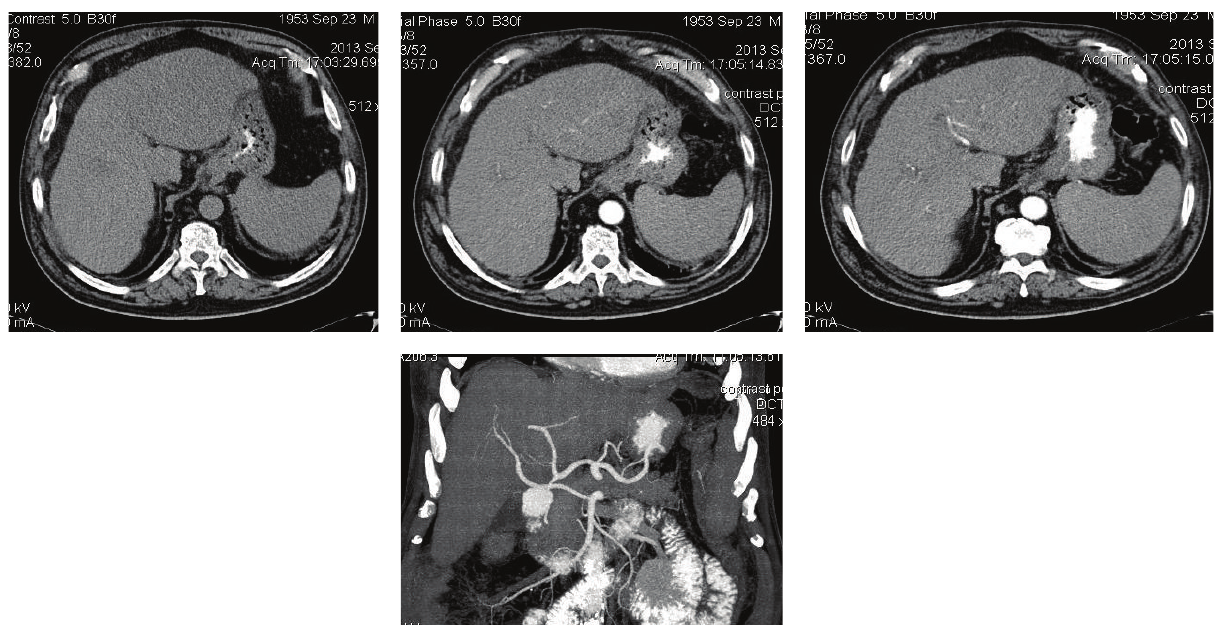
Figure 1: Preprocedure CT (native and arterial phase). Note: superior mesenteric artery type right hepatic artery; left lobe mass main feeder is left hepatic artery.